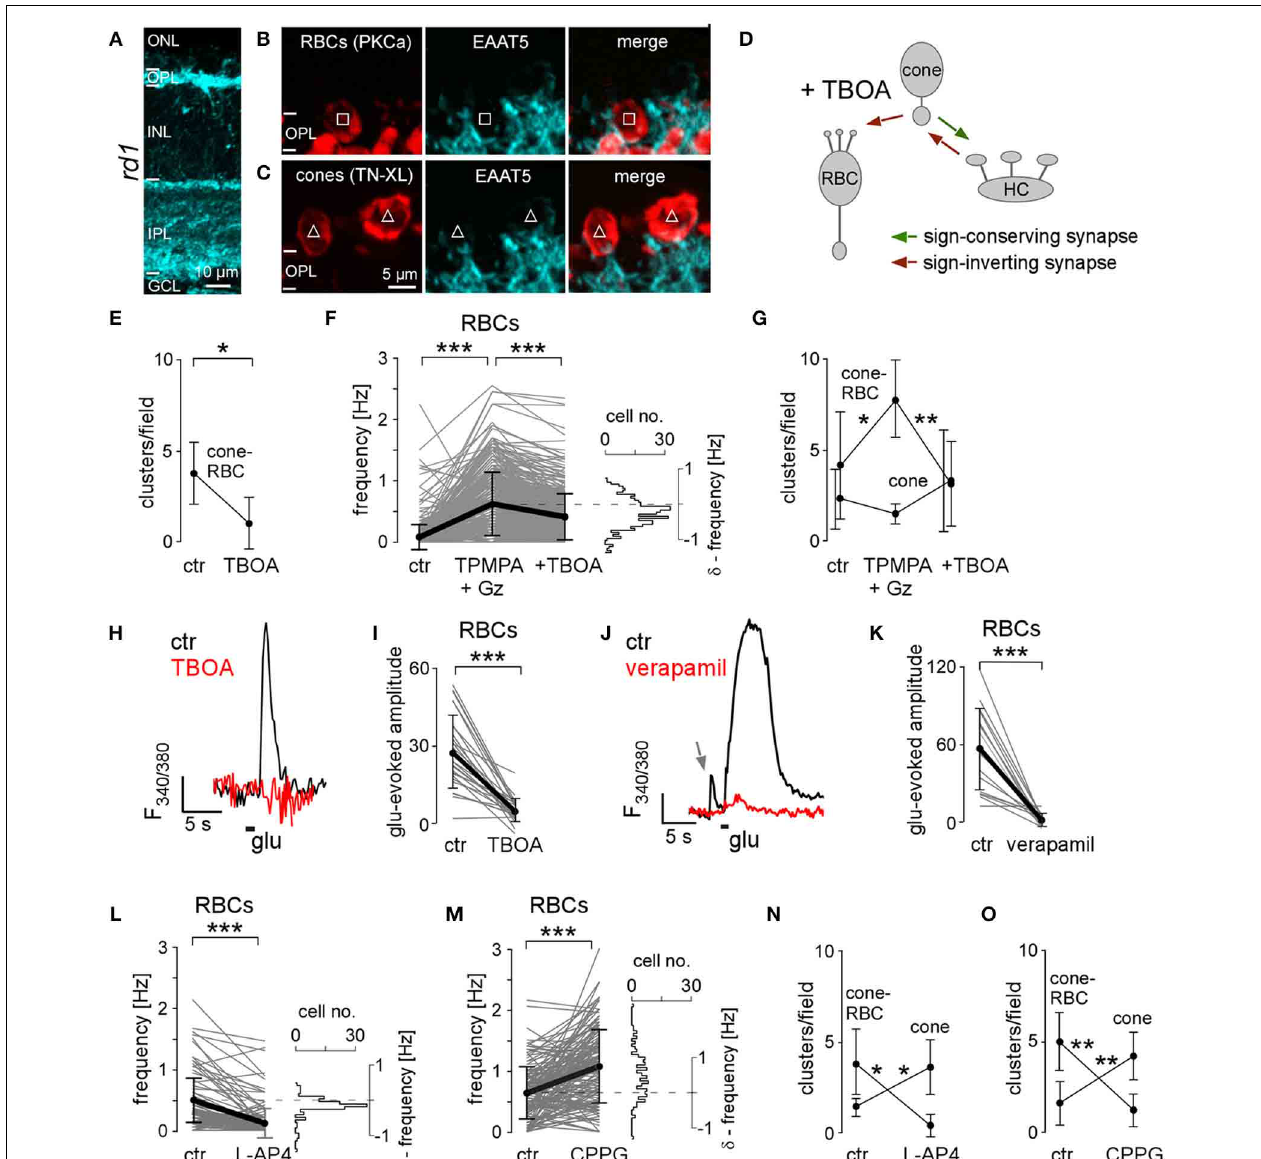
FIGURE 4 | Glutamate transporters mediate input from rd1 cones to rod bipolar cells. (A–C) Vertical sections of P35 rd1 retina immunostained for EAAT5 ( A–C , cyan) and co-labeled for RBCs ( B , PKC α in red, square) or cones ( C , TN-XL in red, triangles). (D) Drawing shows synaptic interactions with glutamate transporter antagonist TBOA blocking sign-conserved cone input to RBCs. (E) Number of cone-RBC clusters before (ctr) and with TBOA. (F) Mean frequency ( F mean ) of Ca 2 + transients in RBCs before (ctr), with GABA receptor blockers (TPMPA+Gz), and with TBOA applied in addition (+TBOA). (G) Effect of the drugs (from F ) on the number of clusters. (H) Example